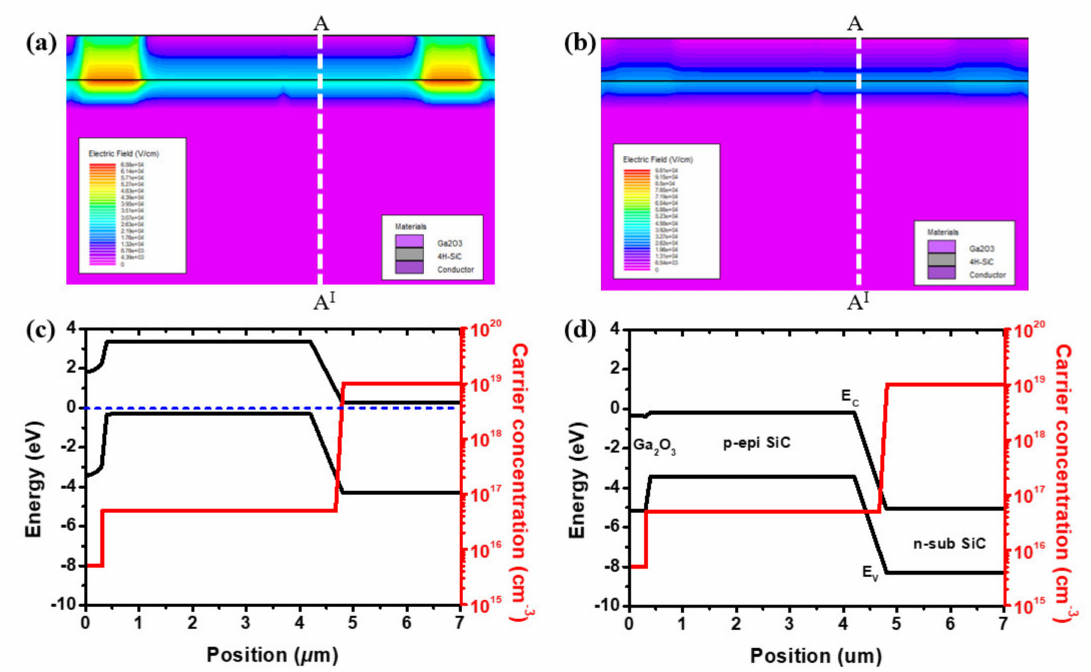
Figure 8. The device structures and energy band diagram of n-Ga 2 O 3 /p-epi/n-sub SiC static induction devices: ( a ) zero gate voltage bias electric field structure, ( b ) applied gate voltage electric field structure, ( c ) zero gate voltage bias energy band, ( d ) applied gate voltage energy